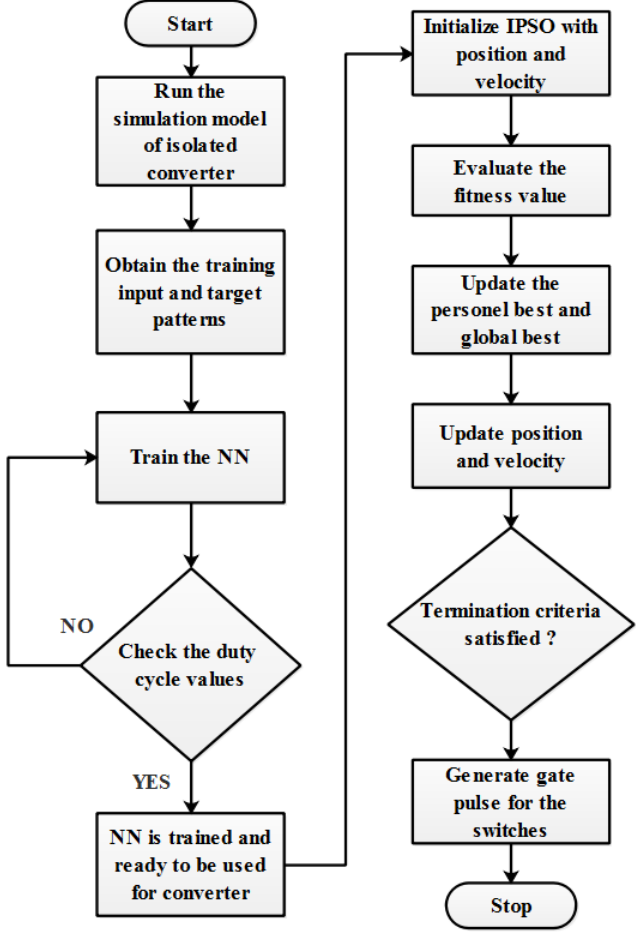
Figure 3. Flowchart of the proposed method.